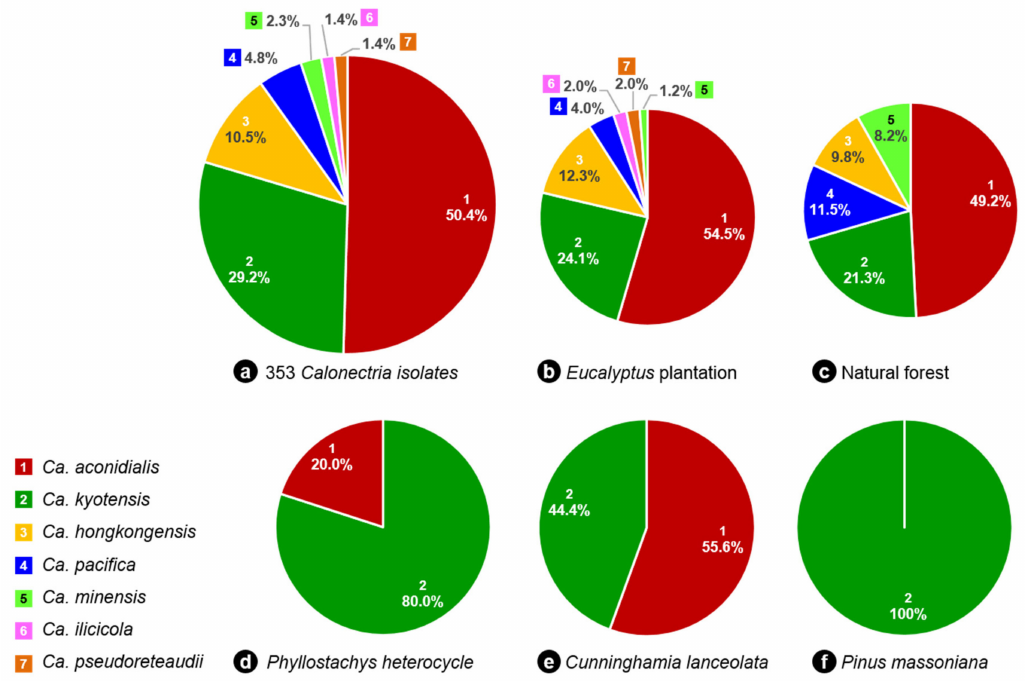
Figure 5. Calonectria species collected from soils of five different types of forests in Fujian Province. ( a ). the percentage of each Calonectria species accounted for all of the species isolated in this study. Different species are indicated by numbers with different colours; ( b – f ). the percentage of each Calonectria species obtained from five different types of